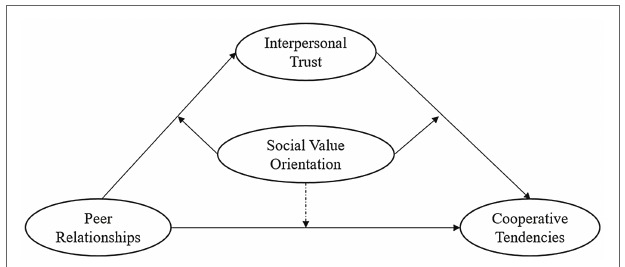
FIGURE 1 | Diagram of the hypothesized moderated mediation